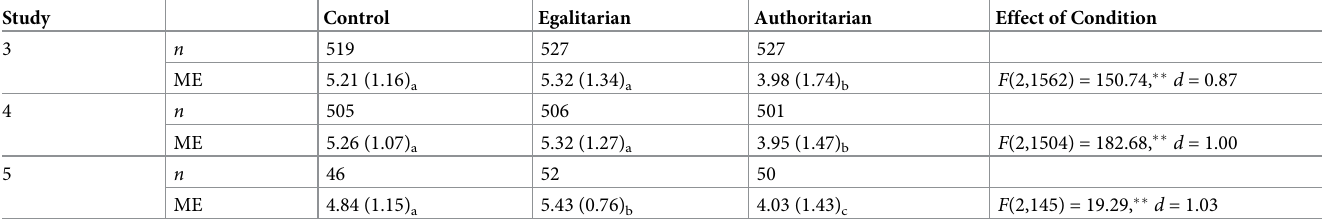
Table 3. Effects of condition on message evaluations, studies 3, 4, and